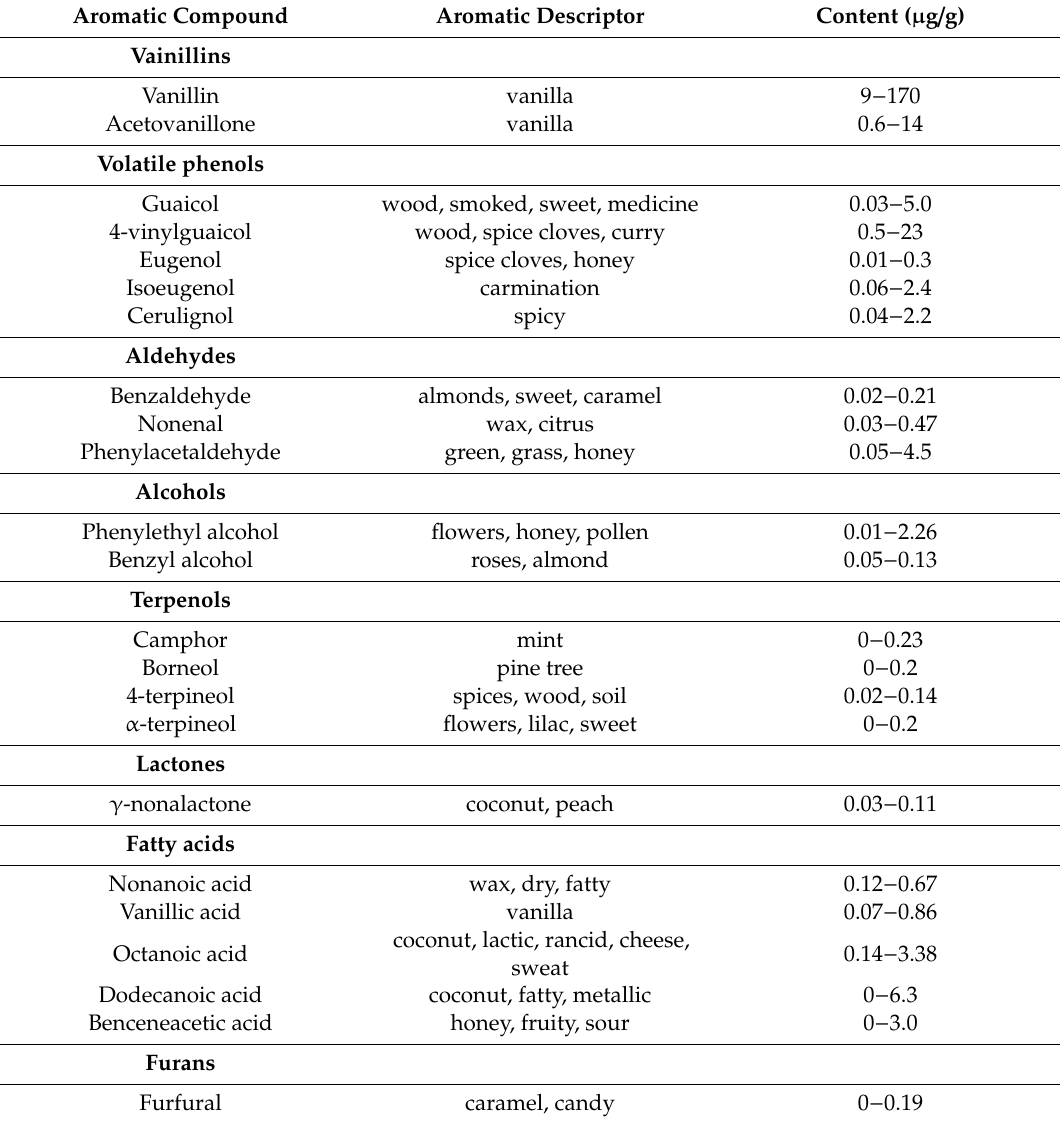
Table 1. Aromatic compounds, families, descriptors, and minimum and maximum content found in the studied granulates and cork